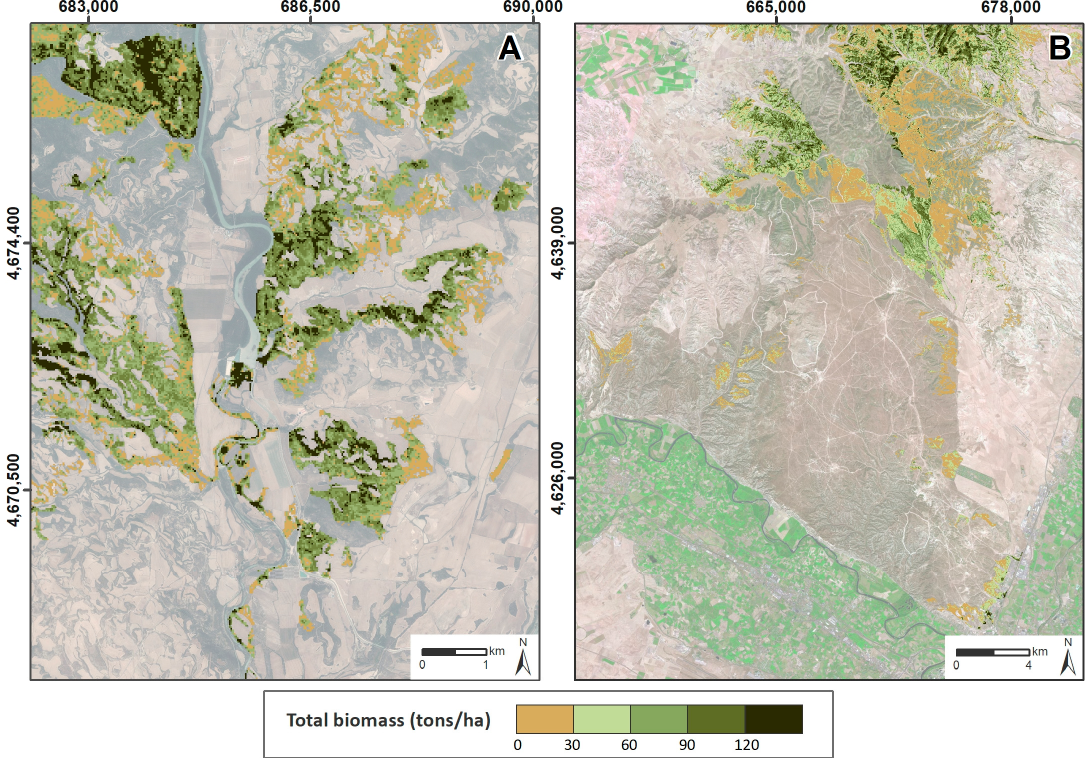
Figure 4. Maps of TB. High spatial resolution orthophotography from Spanish National Plan for Aerial Orthophotography (PNOA) [54] is used as backdrop. Coordinate System: ETRS89 UTM Zone 30 N.